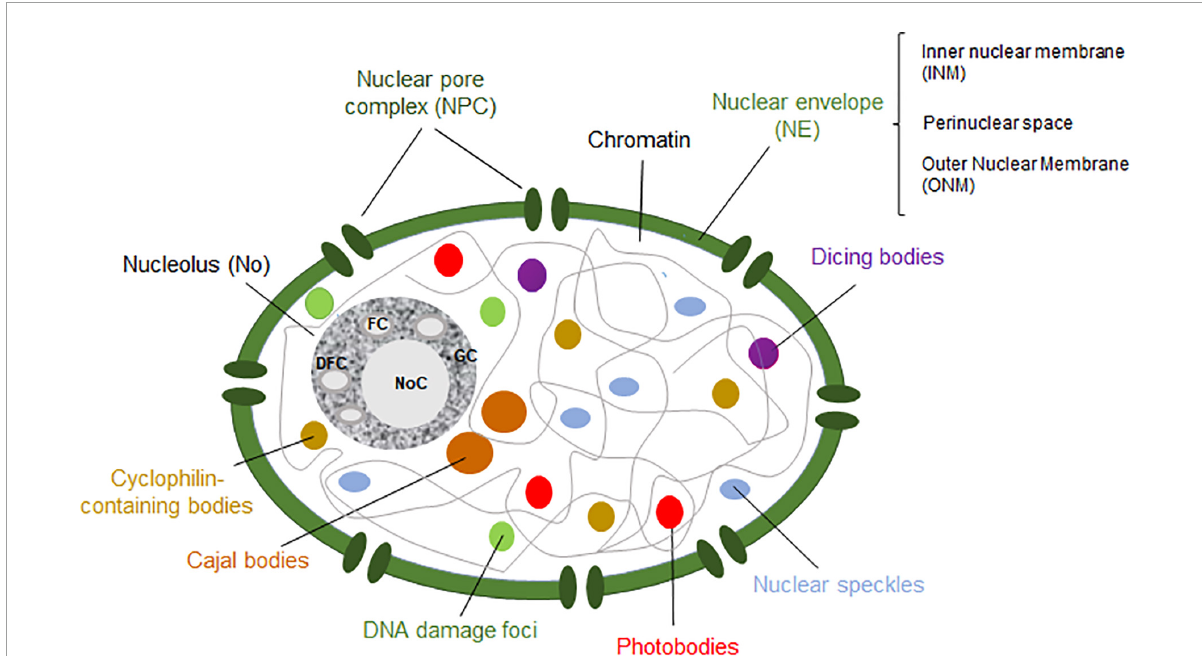
FIGURE1 Schematic representation of a plant nucleus showing the nucleolus (dark gray), Cajal bodies (brown), dicing bodies (purple), nuclear speckles (blue), photobodies (red), cyclophilin-containing bodies (light brown) and DNA damage bodies (green). The nuclear enveloppe (NE) and nuclear pore complex (NPC) are shown in green. The fibrillar centers (FCs), dense fibrillar component (DFC), granular component (GC) and nucleolar cavity (NoC) are ilustrated within the nucleolus. Figure based on Petrovská et al.